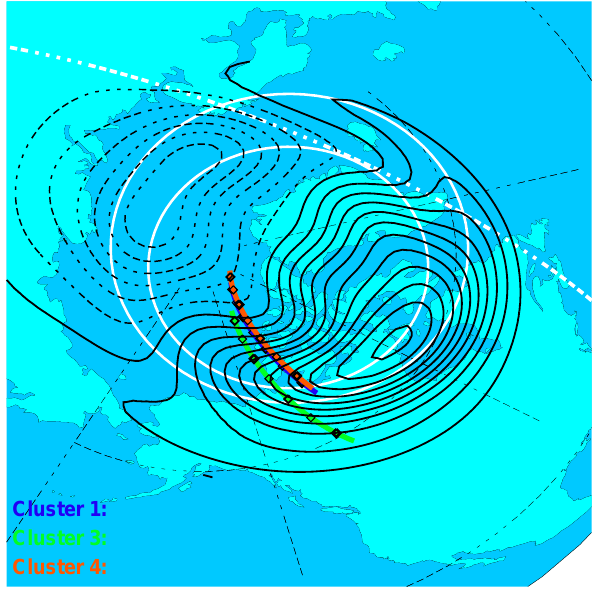
Fig. 2. Magnetic footpoints of the Cluster satellites (SC1 blue, SC3 green, SC4 red) during their cusp crossing at 25 July 2001, to il- lustrate their spatial separation. Also shown are convection cells derived from SuperDARN radar observations for the time period from 23:00UT to 23:30UT.